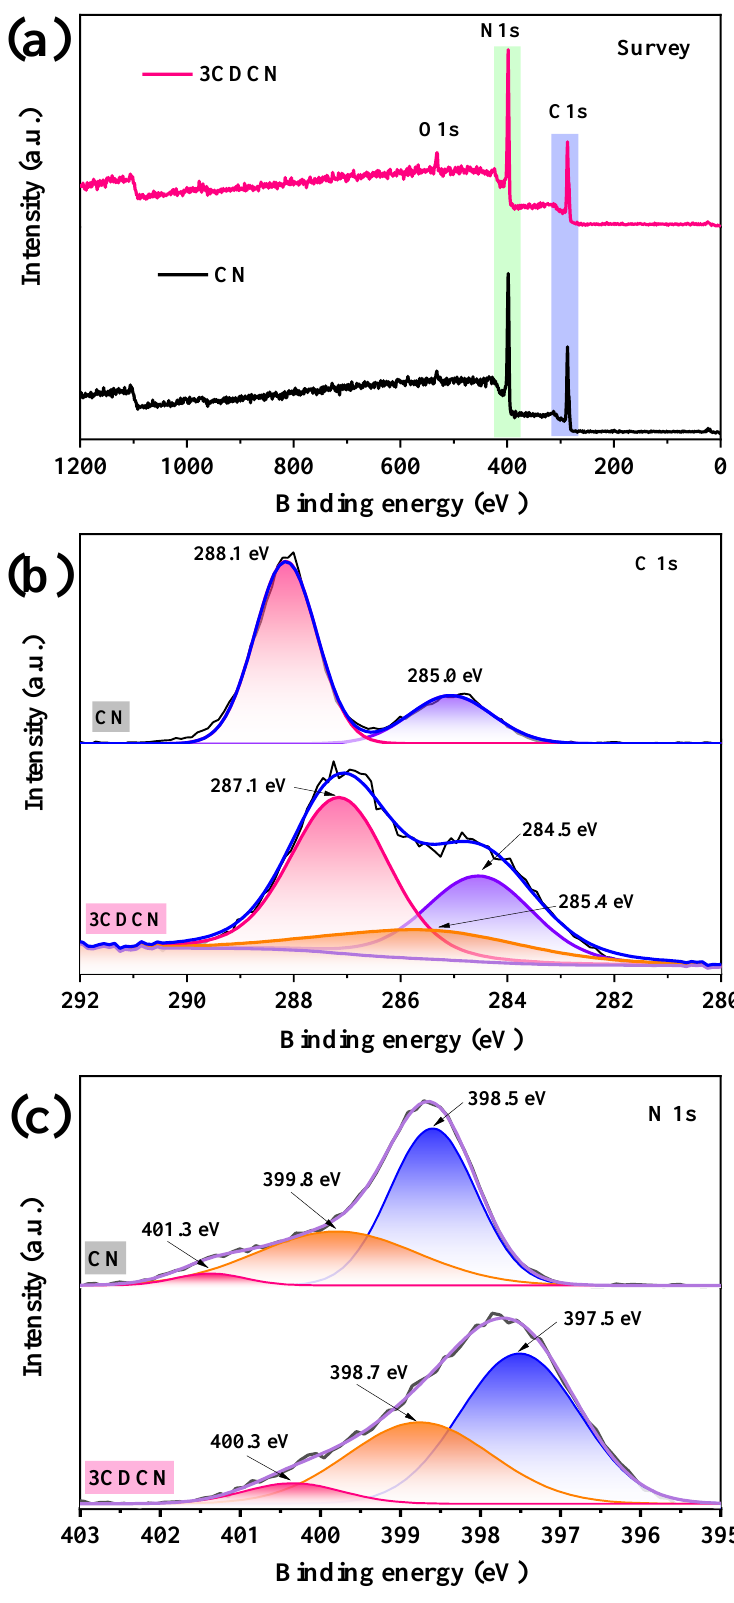
Figure 2. XPS spectra of CN and 3CDCN ( a ) survey spectra, ( b ) the HR-XPS of carbon, and ( c ) the HR-XPS of nitrogen.